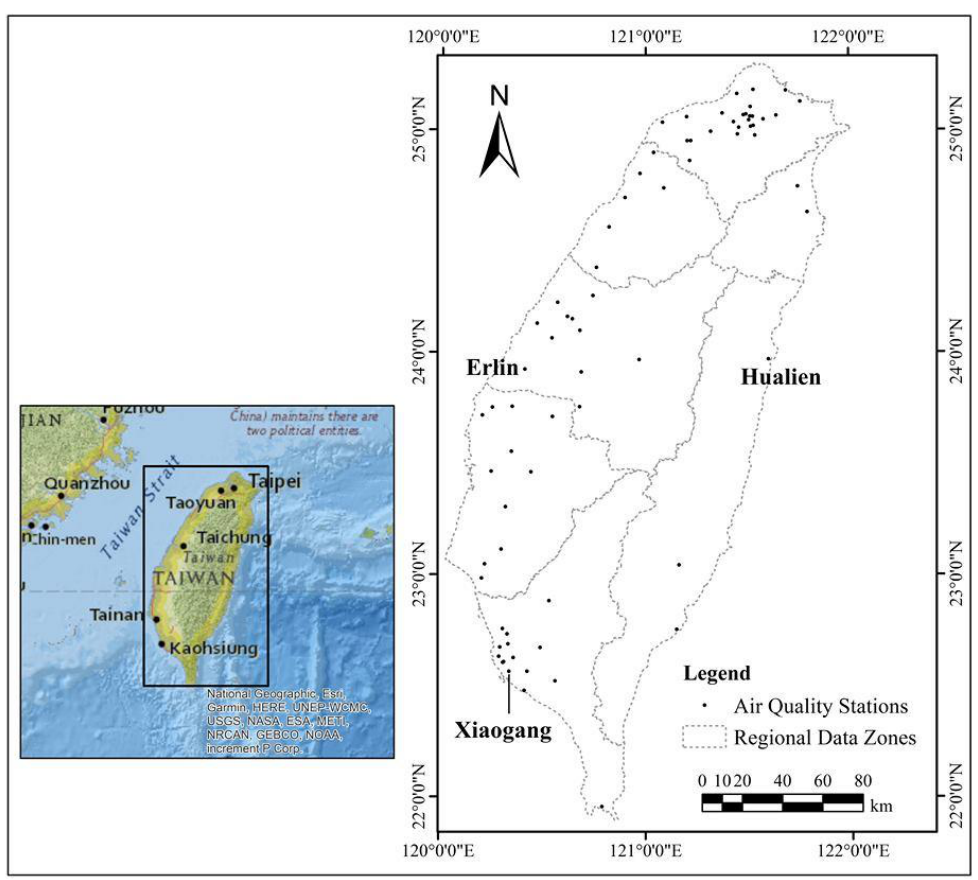
Figure 1. Locations of PM 2.5 monitoring stations.